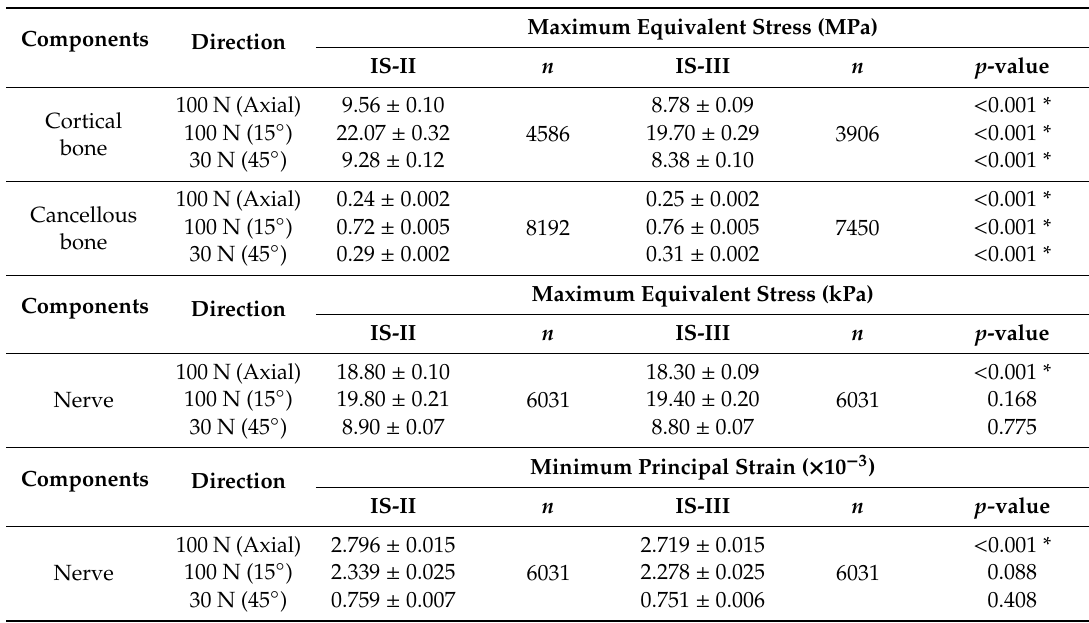
Table 3. The Max EQS and minimum principal strain (compressive strain) results (mean ± SEM) of IS-II and IS-II fixtures for cortical bone, cancellous bone, and the nerve surface (* p -value < 0.01). Components